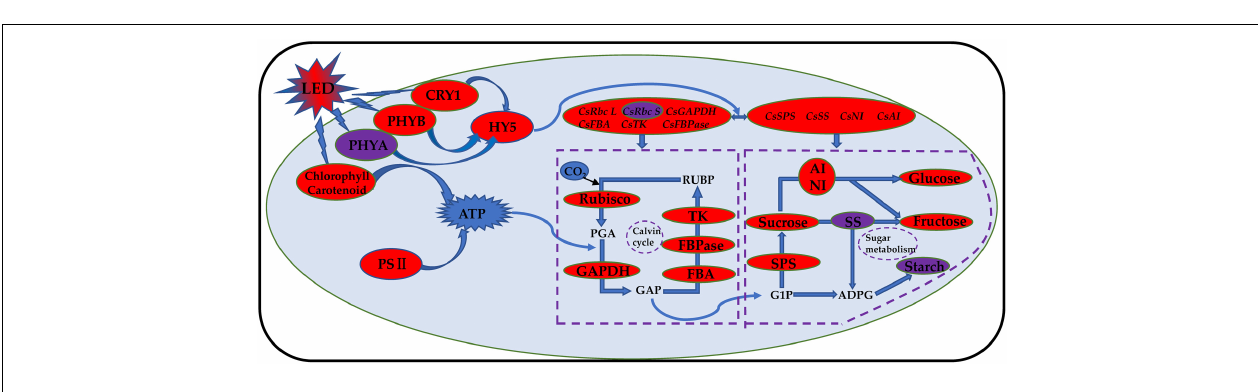
FIGURE 11 | Schematic model of photosynthesis response of cucumber to red and blue LED supplemental light. The red and blue LED light supplement can improve the photosynthetic capacity of cucumber and promote the accumulation of photosynthetic products by regulating the transcriptional level and activity of photoreceptors, core light signal regulators, Calvin cycle enzyme, and glucose metabolism enzyme; improve the photosynthetic pigment content; and promote the opening of the reaction center of cucumber leaf photosystem II. The increase is indicated by the red oval. The decrease is indicated by the purple